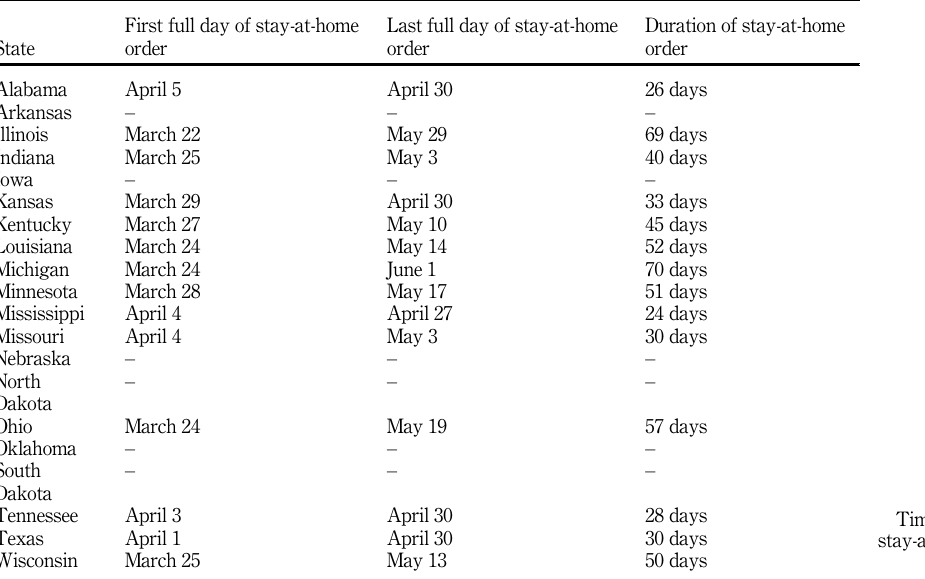
Table 1. Timing of